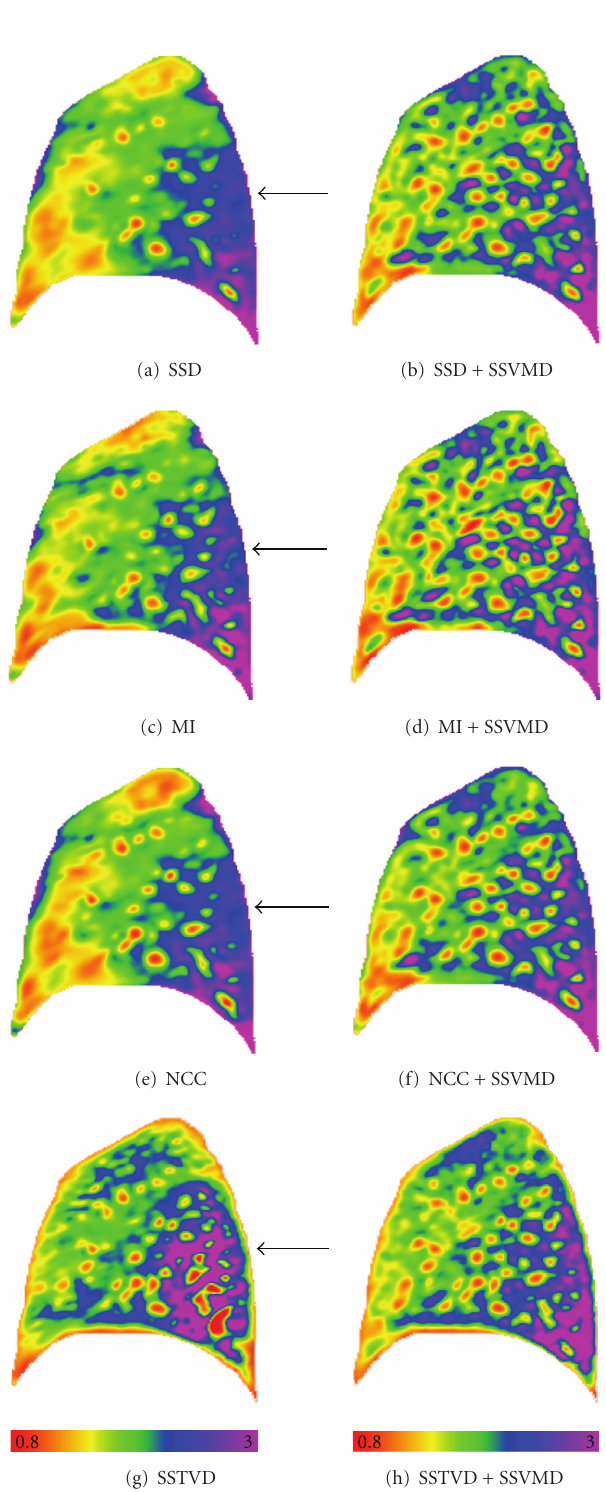
Figure 9: The color-coded Jacobian maps of a sagittal slice resulted from eight registration methods. Blue and purple regions have larger lung deformation, while red and orange regions are deforming less. Arrows denote regions which show di ff erent deformation patterns using intensity-only registration